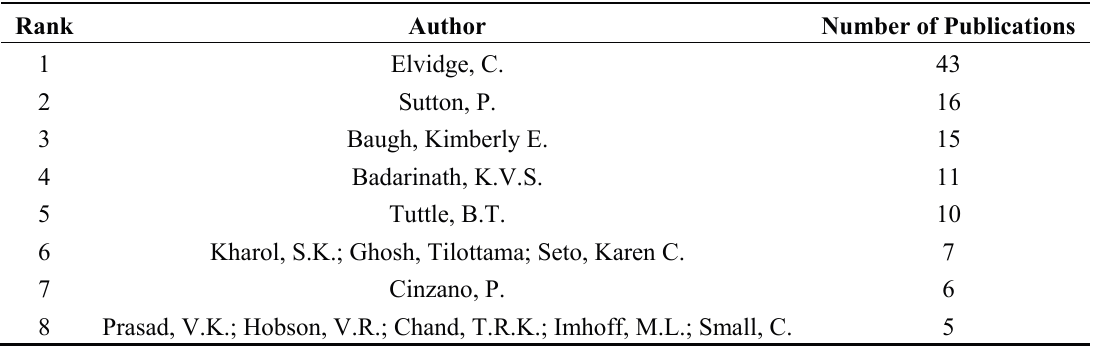
Table 3. Top eight most productive authors.